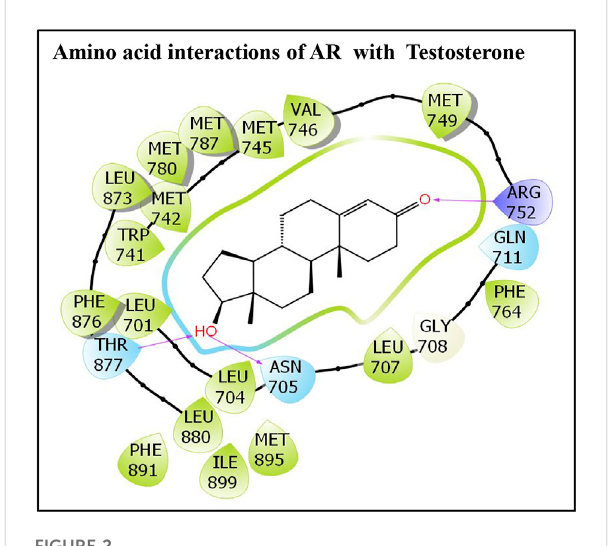
FIGURE 2 Molecular interactions of an AR native ligand, testosterone, with residues lining AR ligand-binding